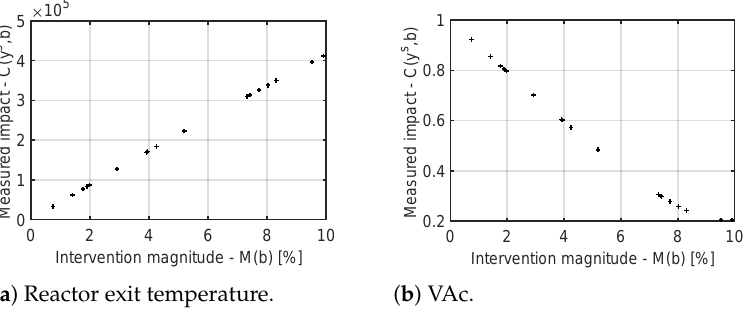
Figure 9. Attestation result on two observable variables with intervention on the C 2 H 4 feed